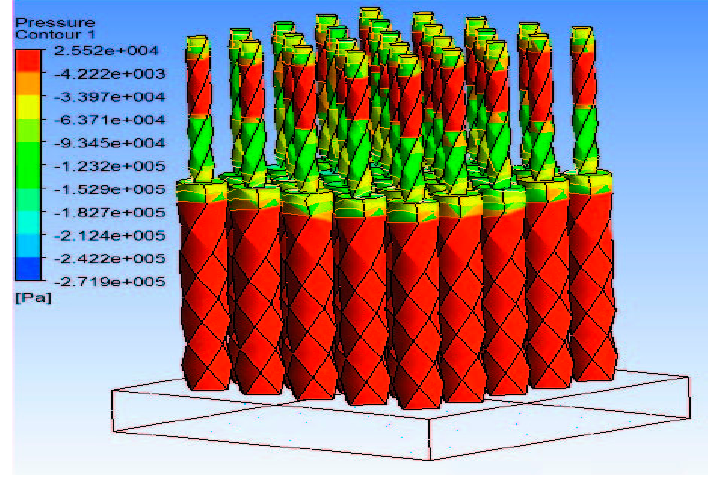
Figure 3. Pressure distribution along dual radii MN array (adopted from [79]).